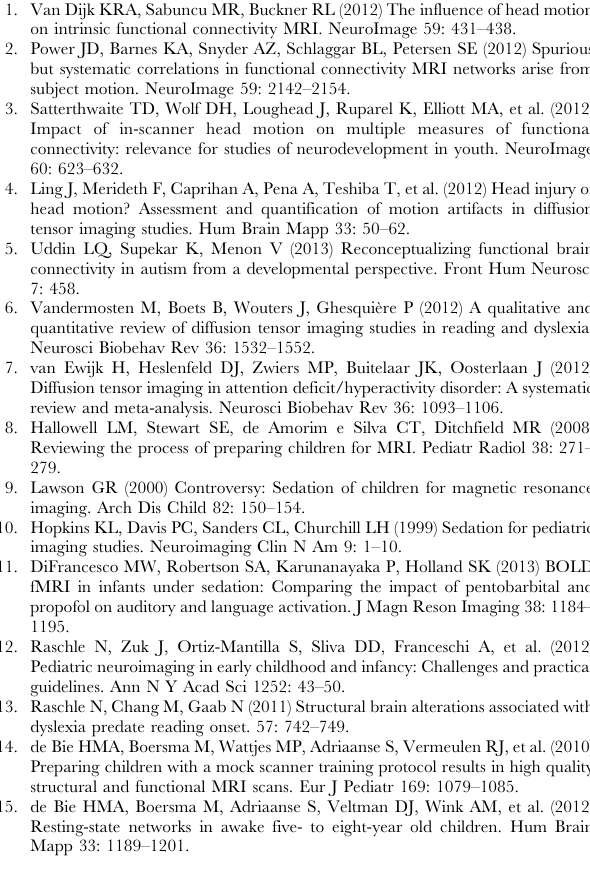
Table S1 Demographics and motion parameters for the